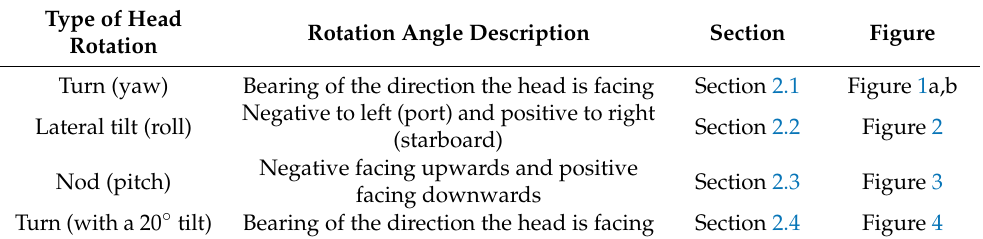
Table 2. Meanings of the rotation angles (Table 1) in three orthogonal head rotations for which acoustic images are generated (Figures 1–3) and for a fourth rotation in which a turn (yaw) incorporates a constant lateral tilt (roll) downslope to the right across the head (Figure